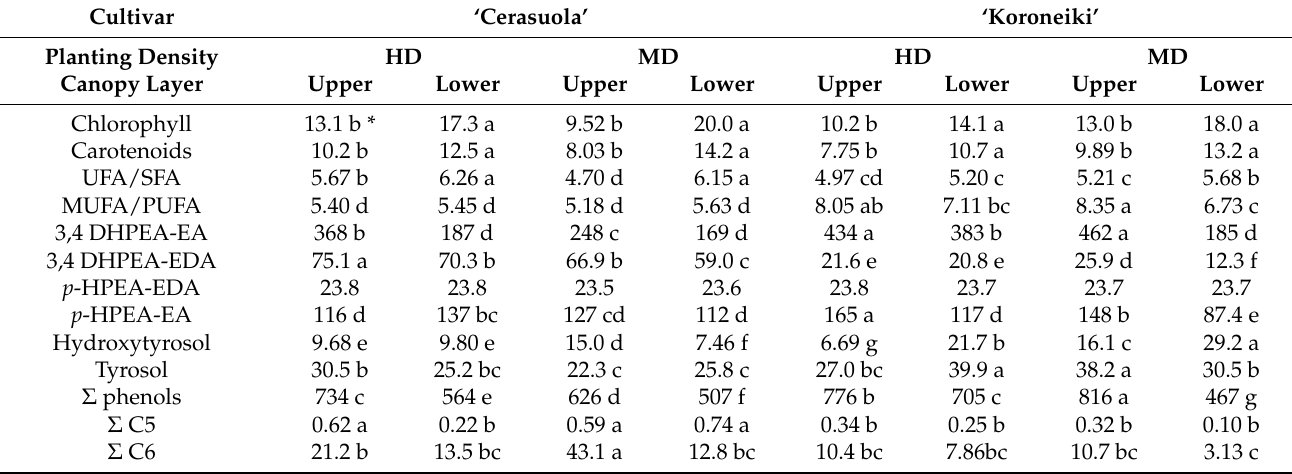
* Values followed by the same letters in each row are not significantly different by Tukey’s test at α < 0.05 ( n =